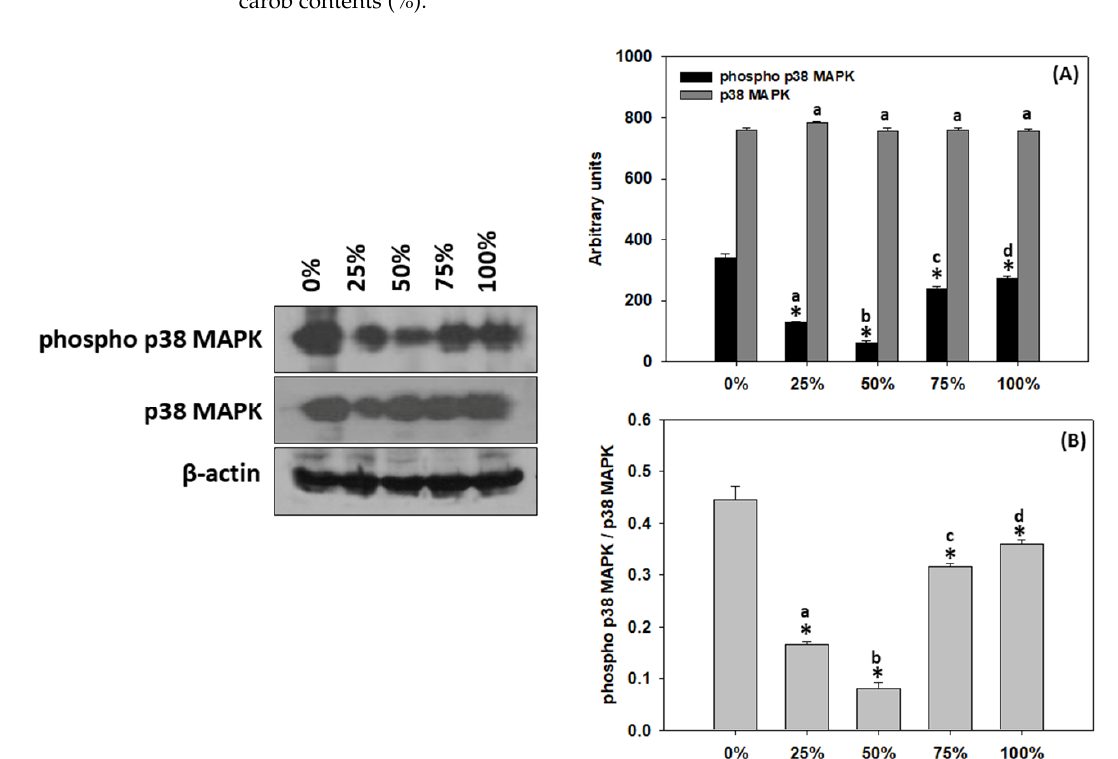
Figure 7. ( A ) Phosphorylated p38 MAPK, p38 MAPK and ( B ) phosphorylated p38 MAPK/p38 MAPK levels (mean ± SD) of Tenebrio molitor larvae reared on substrates containing different content levels of milled carob pods (0, 25, 50, 75 and 100%). Asterisk (*) indicates p < 0.05 compared to 0%, while lower case letters indicate p < 0.05 compared to different carob contents (%).